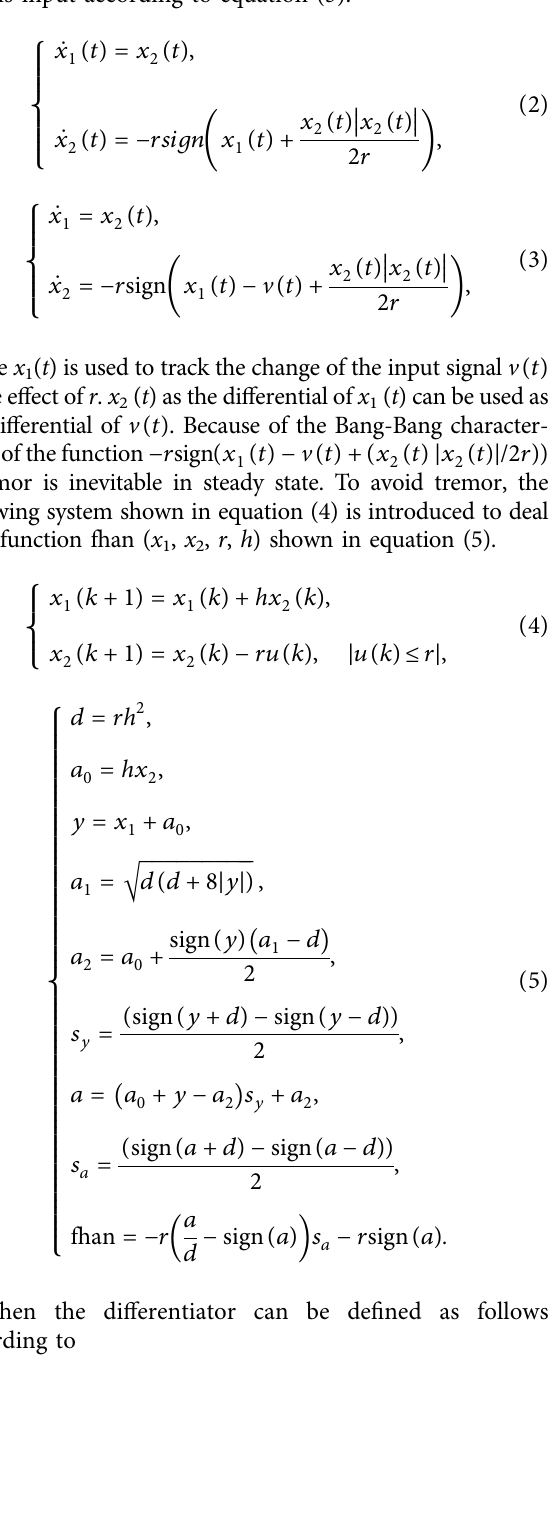
Figure 4: Principle of the “adding transition Te fastest closed-loop feedback control system of the second-order integrator is shown in equation (2). Te signal v ( t ) is input according to equation (3).